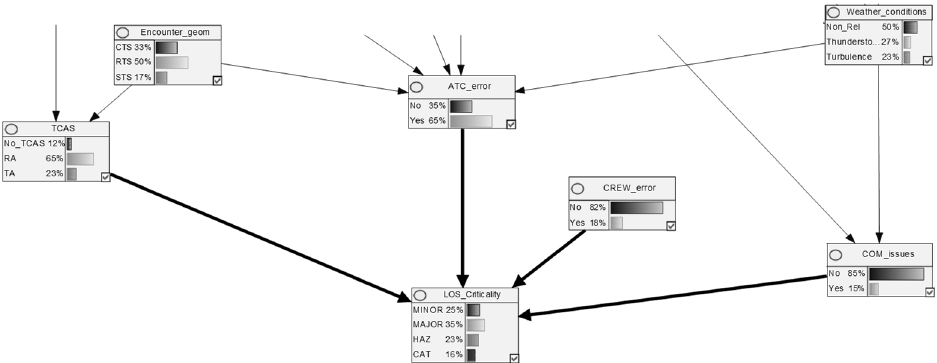
Figure 11. Strength of influence on the node of the target variable.